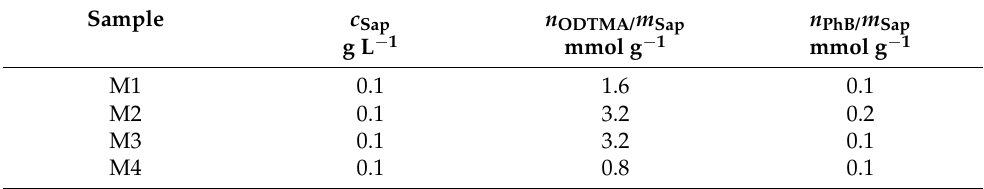
Table 1. The compositions of colloidal dispersions of Sap, ODTMA, and PhB, which were used for the preparation of organoclay films and polyurethane composite membranes tested in preliminary experiments